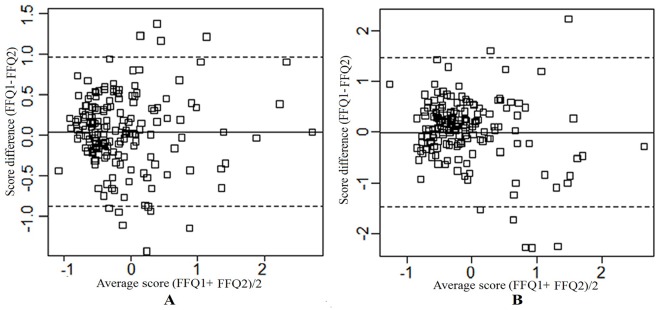
Bland–Altman plots for scores of prudent pattern and processed food pattern derived from FFQ1and FFQ2.A: Prudent pattern; B, Processed food pattern; FFQ1-FFQ2, the patterns score difference of FFQ1 and FFQ2; (FFQ1+FFQ2)/2, average pattern scores of FFQ1 and FFQ2. The solid line represents the mean difference (FFQ1-FFQ2) and the dash lines represent the limits of agreements (mean difference ± 1.96 standard deviations).